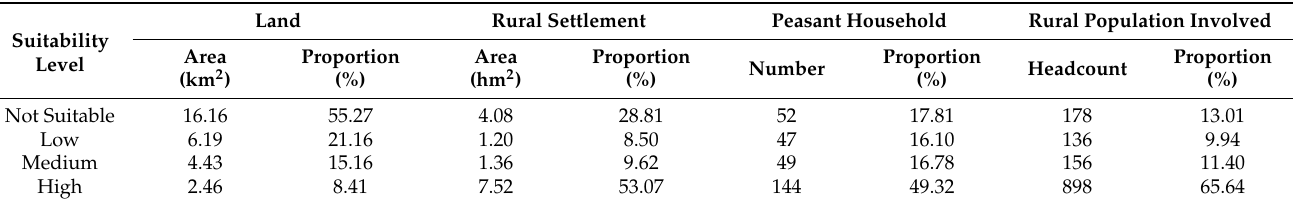
Table 5. Spatial differentiation of rural settlements according to land suitability.